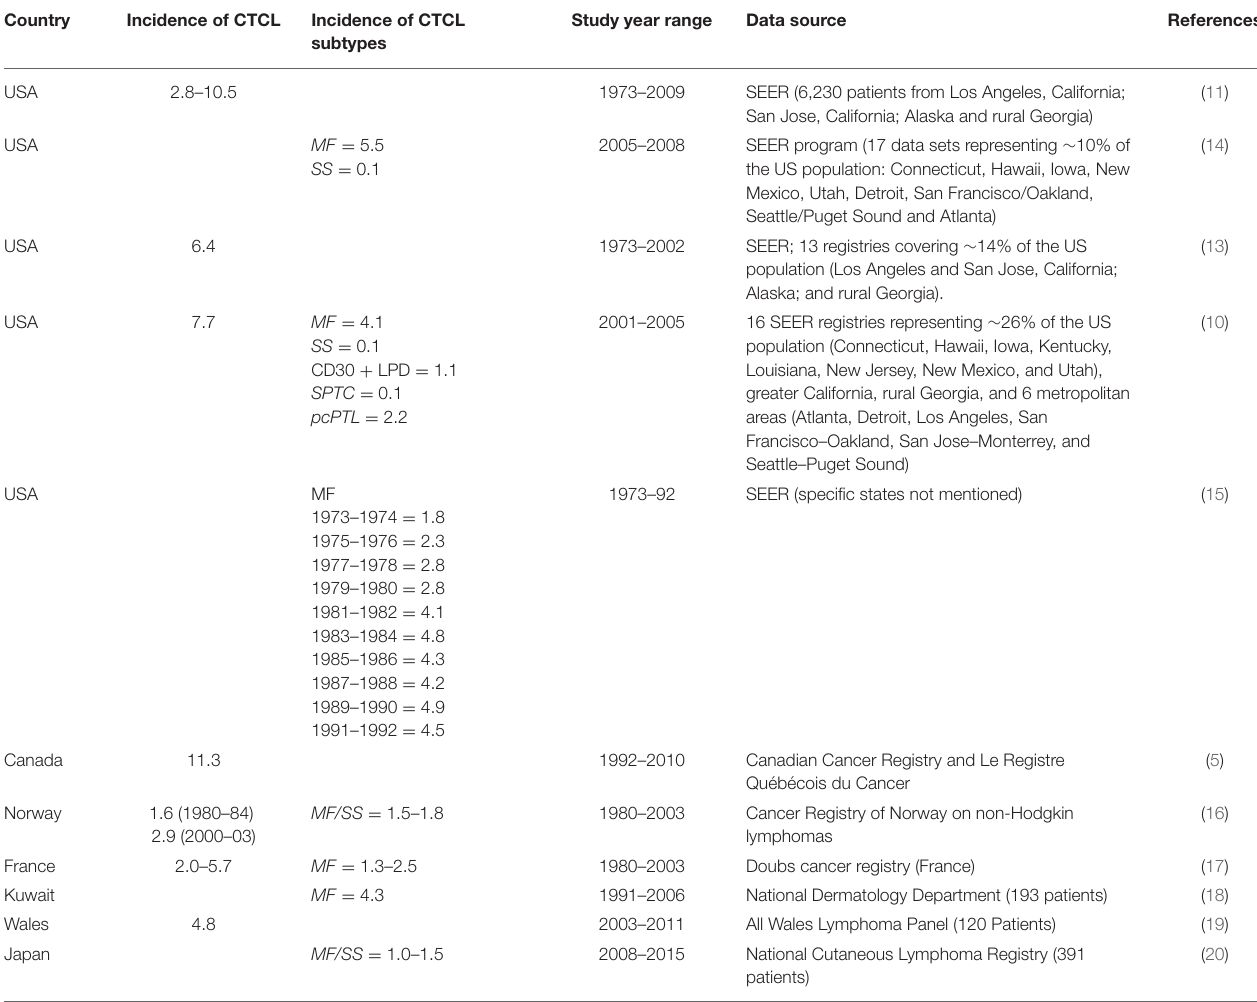
TABLE 1 | Reported CTCL incidence rates worldwide (rates are denoted as cases per 1 million individuals per